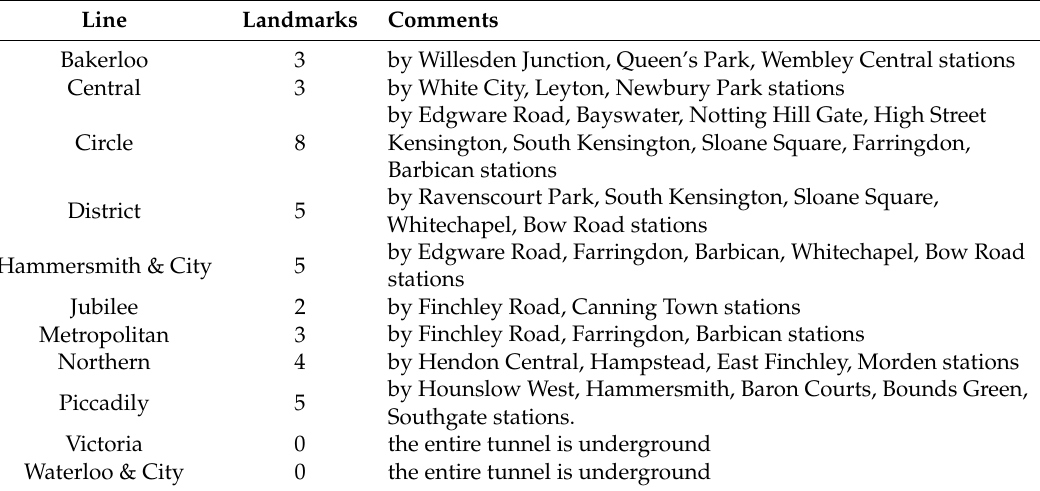
Table 2. Summary of the open-air landmarks recorded in the test